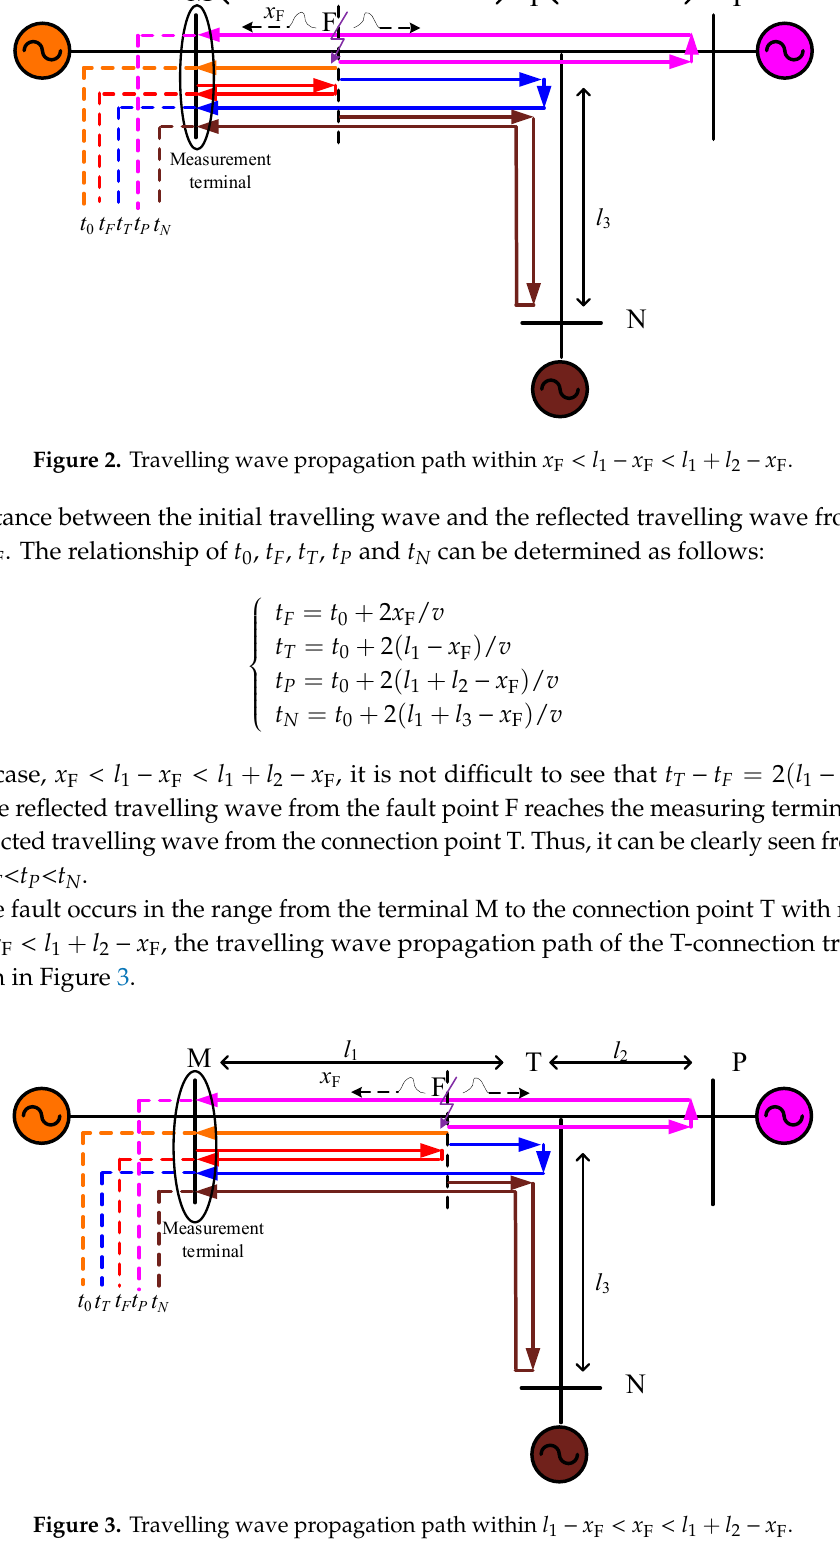
Table 3. Travelling wave types with their reach times.